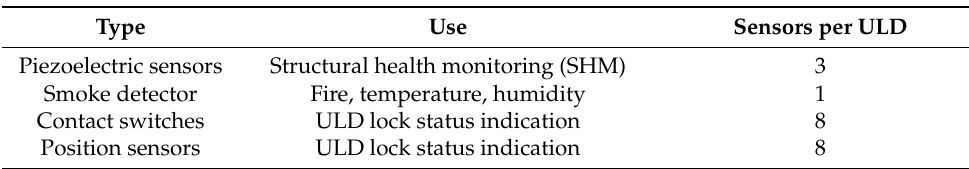
Table 1. Type of sensors mounted on